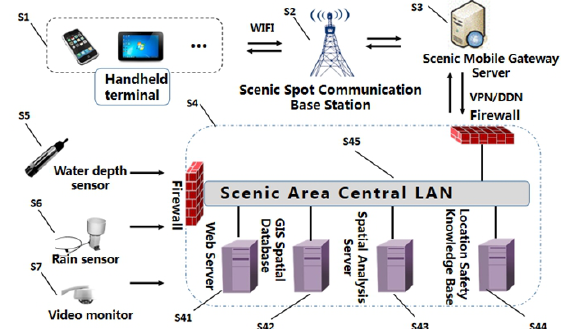
Figure 7. Composition of information acquisition system module for location security